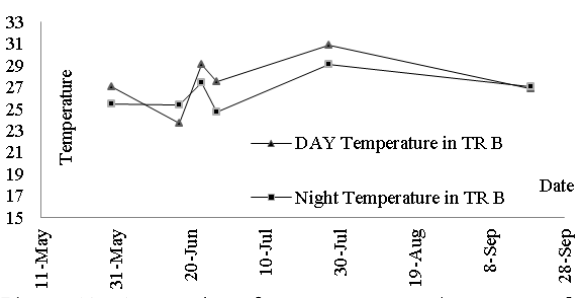
Figure 13: Averaged surface temperatures in test sample (treatment B), in day and night time Besides, differences in treatment temperatures in both day- and nighttime are informative (Figures 14 and 15).